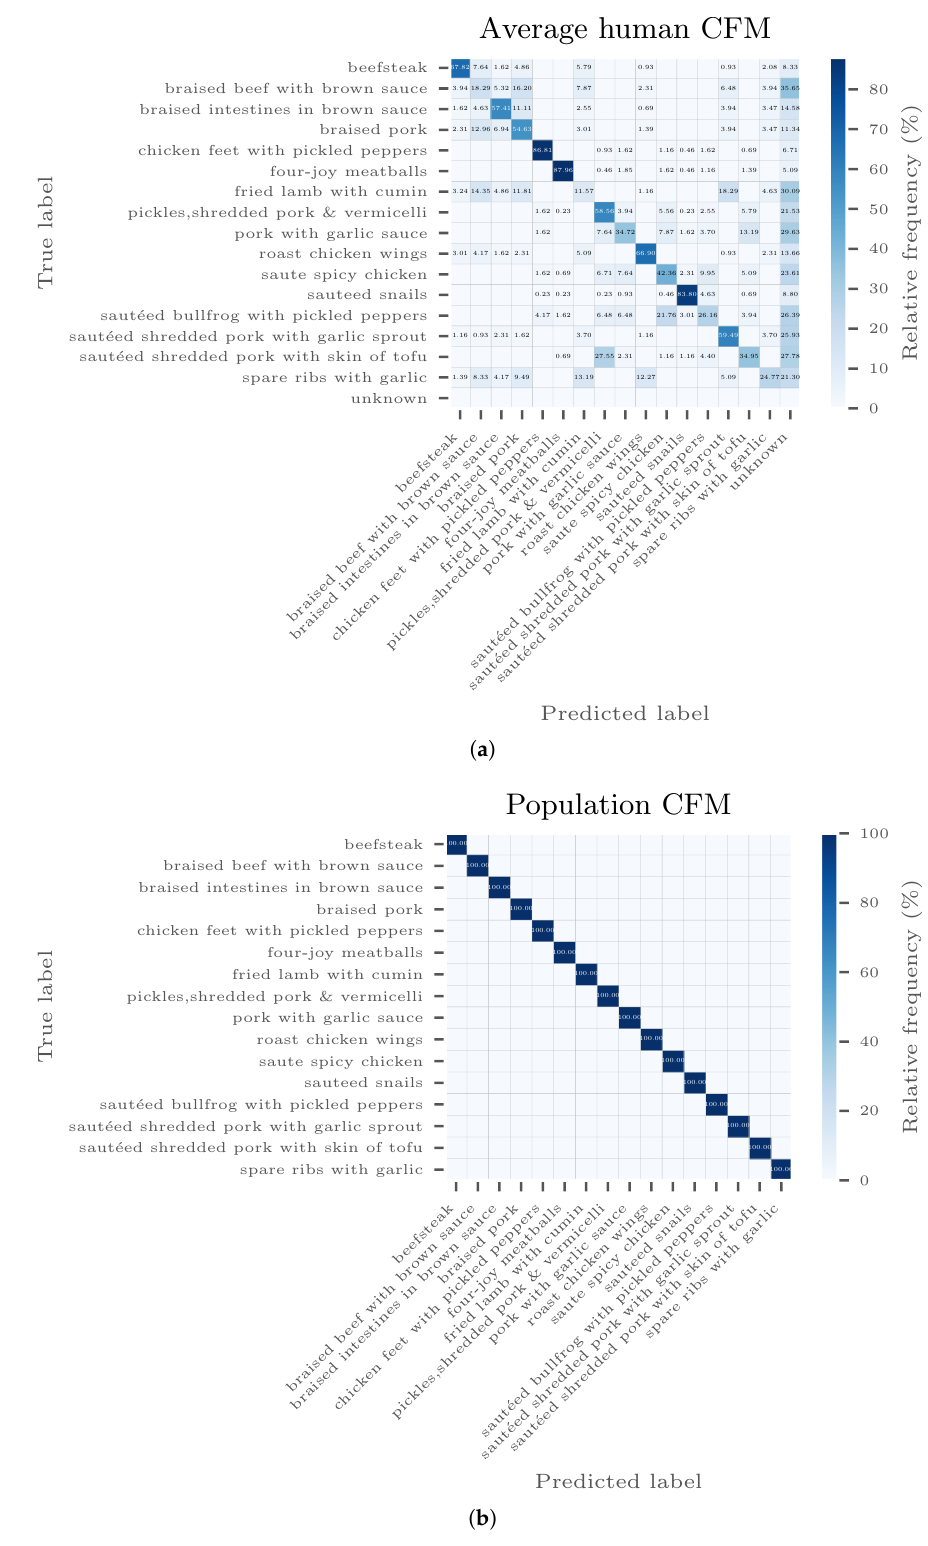
Figure A4. Average human ( a ) and population ( b ) CFMs for the ASIA population of the VireoFood-172